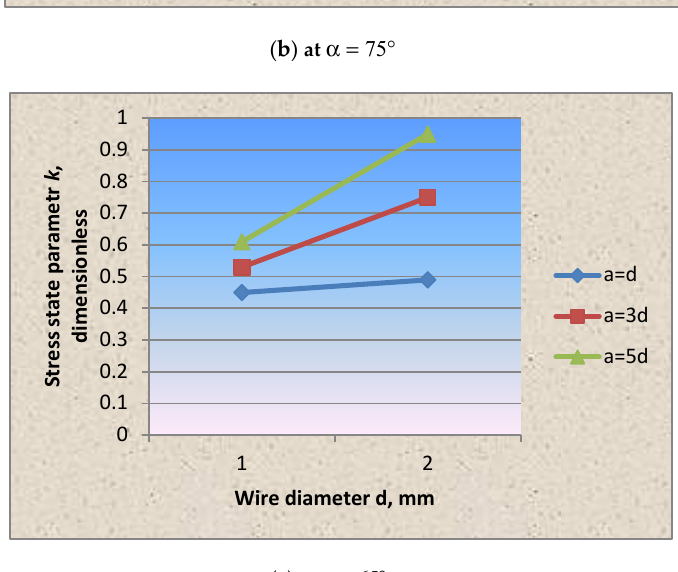
Figure 8. Dependence of the stress state parameter on the winding wire thickness at fixed values of the winding angle of the wrapping thread: ( a ) at a winding angle of 90 degrees, ( b ) at a winding angle of 75 degrees, ( c ) at a winding angle of 65 degrees It was found that together with the wrapping thread’s winding angle, the diameter of the wire selected for wrapping can be the structural control parameter that allows con- trolling the stressed state of the prestressed steel shell structure.